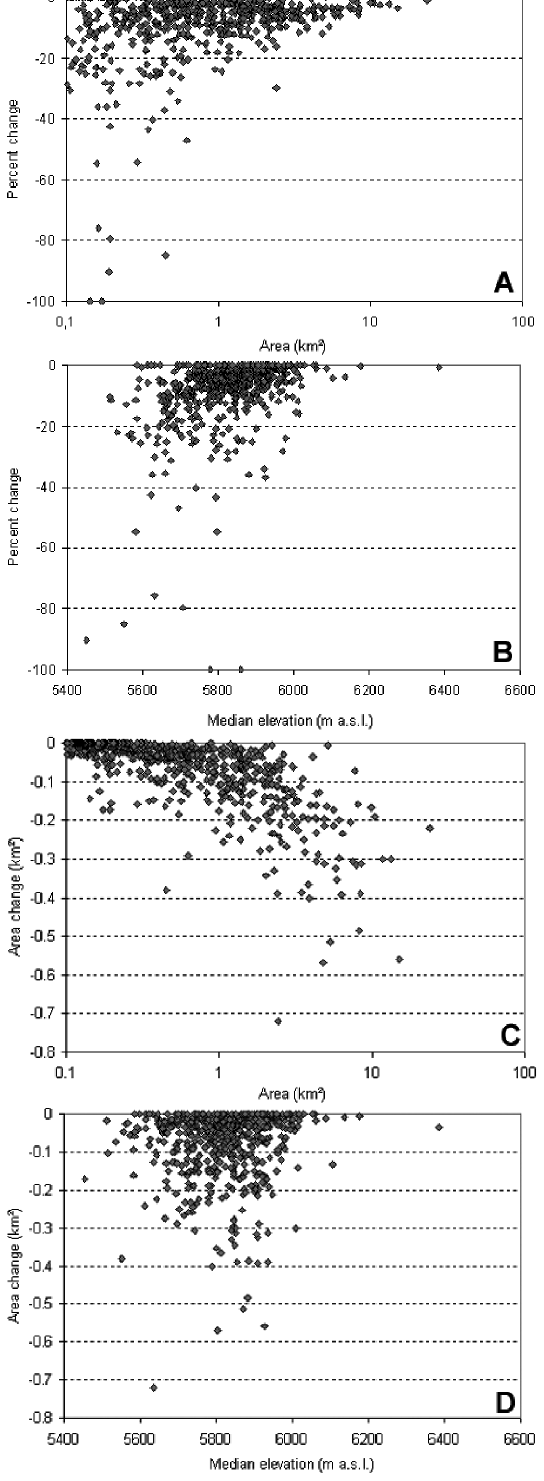
Fig. 7. Relative change in glacier area 1976–2001 versus ini- tial glacier area (A) and median elevation (B) , absolute change in glacier area 1976–2001 versus initial glacier area (C) and median elevation (D) .